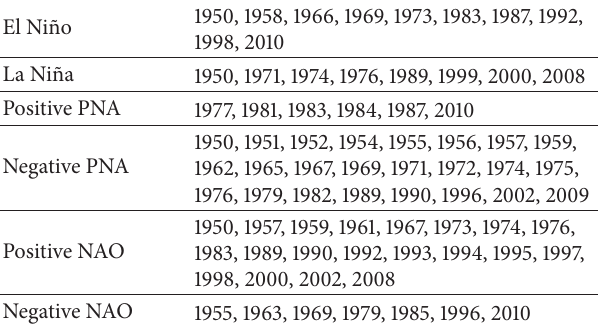
Table 2: Years used in composite study for El Ni˜no, NAO, and IOD (JFM except OND for